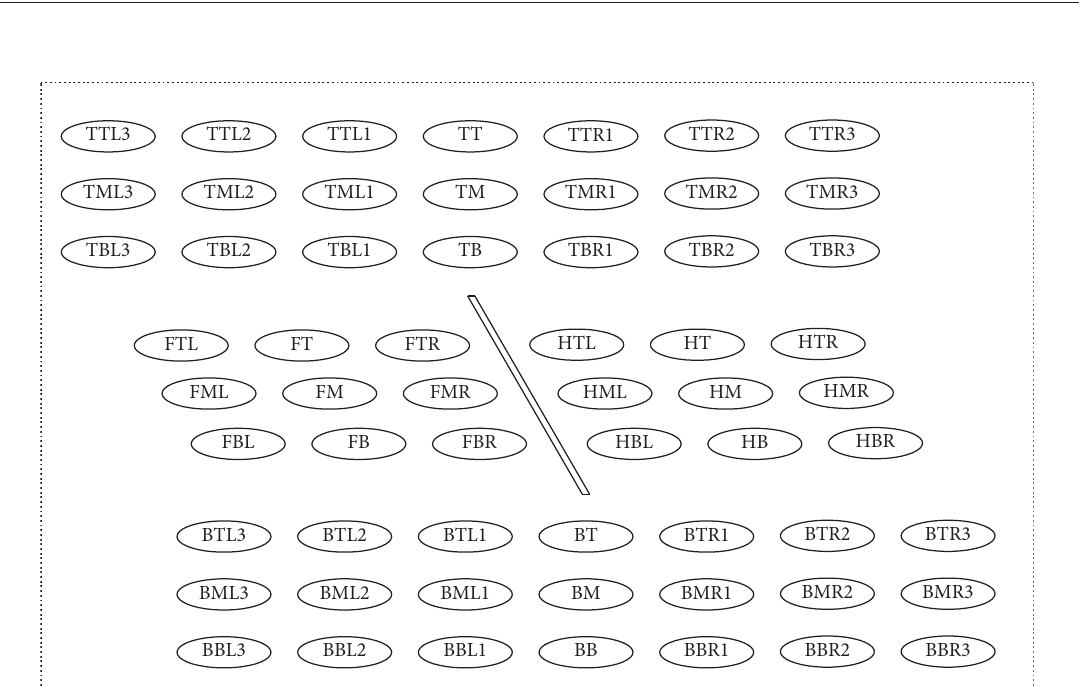
Figure 4: Comprehensive design of the fracturing regions in EGS engineering.